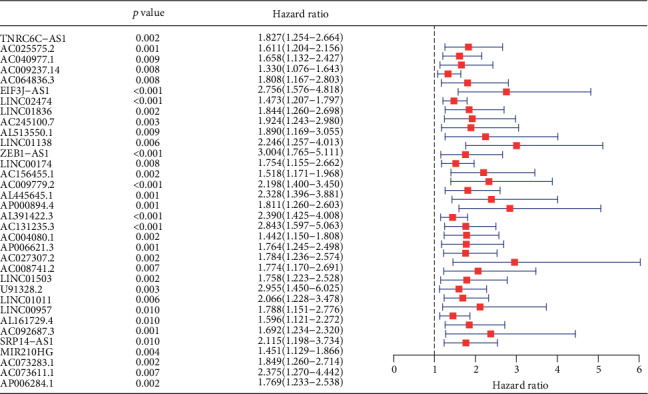
Univariate Cox regression showed that 34 immune-related lncRNAs were risk factors for COAD patients (hazard ratio > 1).